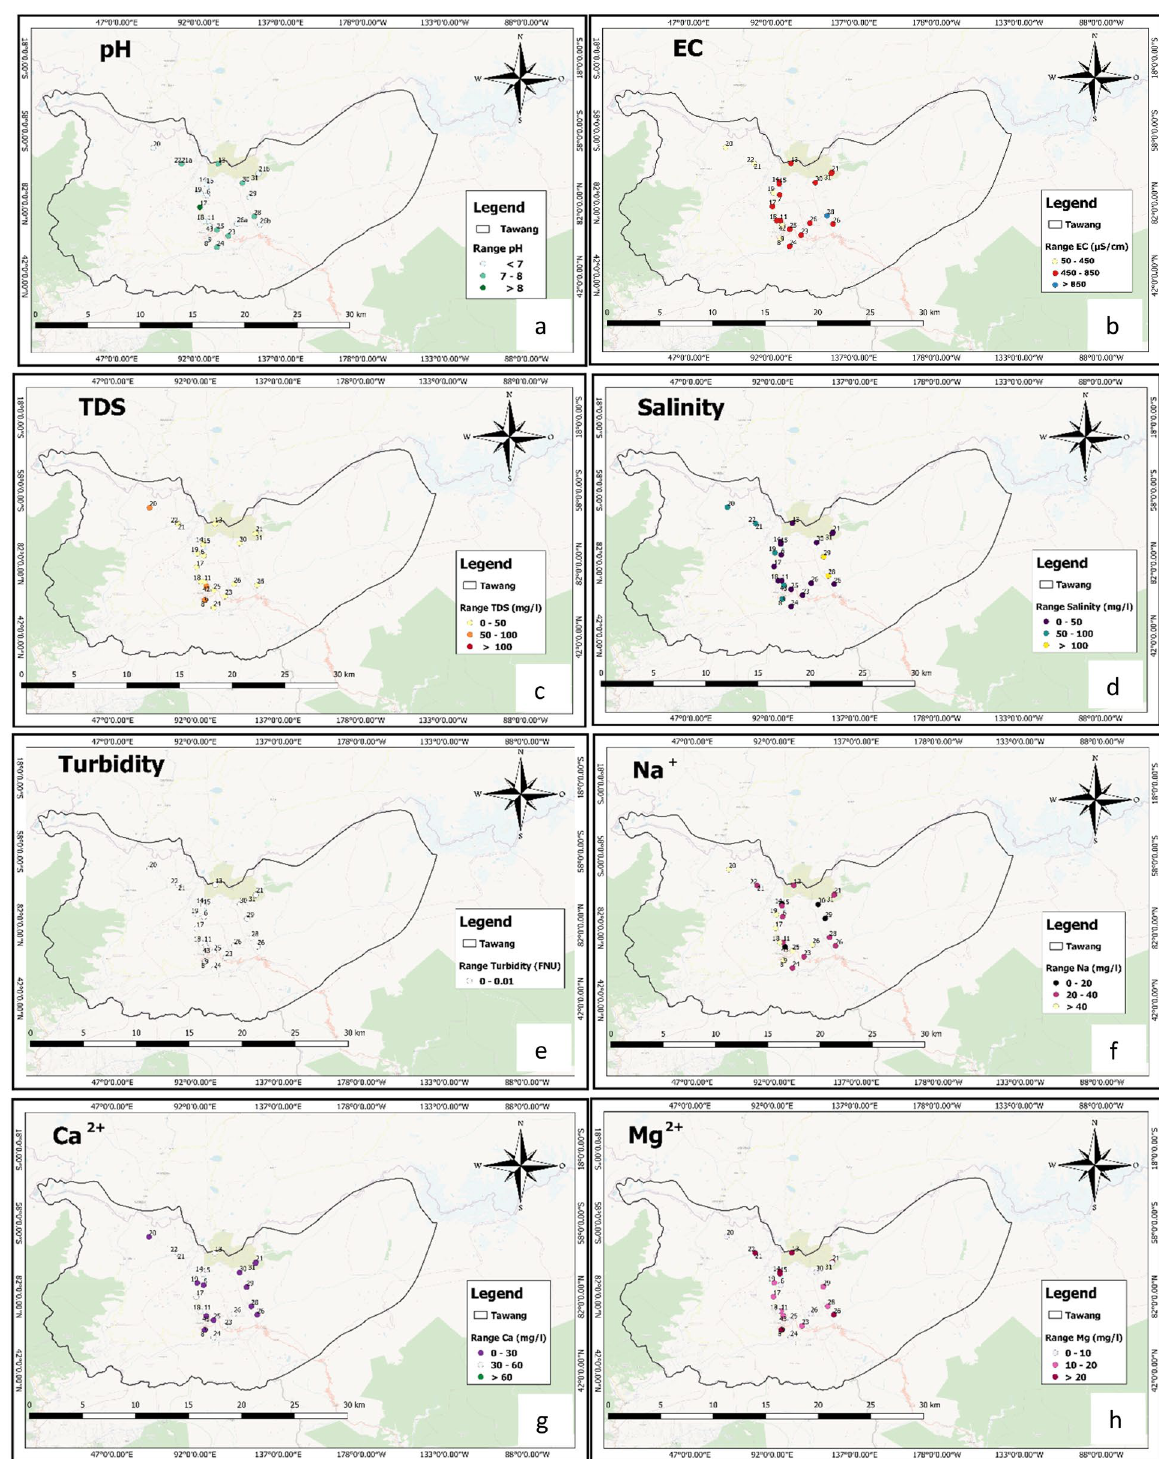
Figure 2. Spatial distribution map of ( a ) pH, ( b ) EC, ( c ) TDS, ( d ) Salinity, ( e ) Turbidity, ( f ) Sodium (Na + ), ( g ) Calcium (Ca 2+ ) and ( h ) Magnesium (Mg 2+ ). Spatial distribution map of ( i ) Potassium (K + ), ( j ) Iron (Fe 2+ ), ( k ) Chloride (Cl - ), ( l ) Bromide (Br - ), ( m ) Fluoride (F - ), ( n ) Nitrite (NO 2- ), ( o ) Nitrate (NO 3- ), ( p ) Phosphate (PO 43- ) and ( q ) Sulphate (SO 42- ) QGIS Software Desktop 3.18.3 (https:// qgis. org/ en/ site/ forus ers/ downl oad.